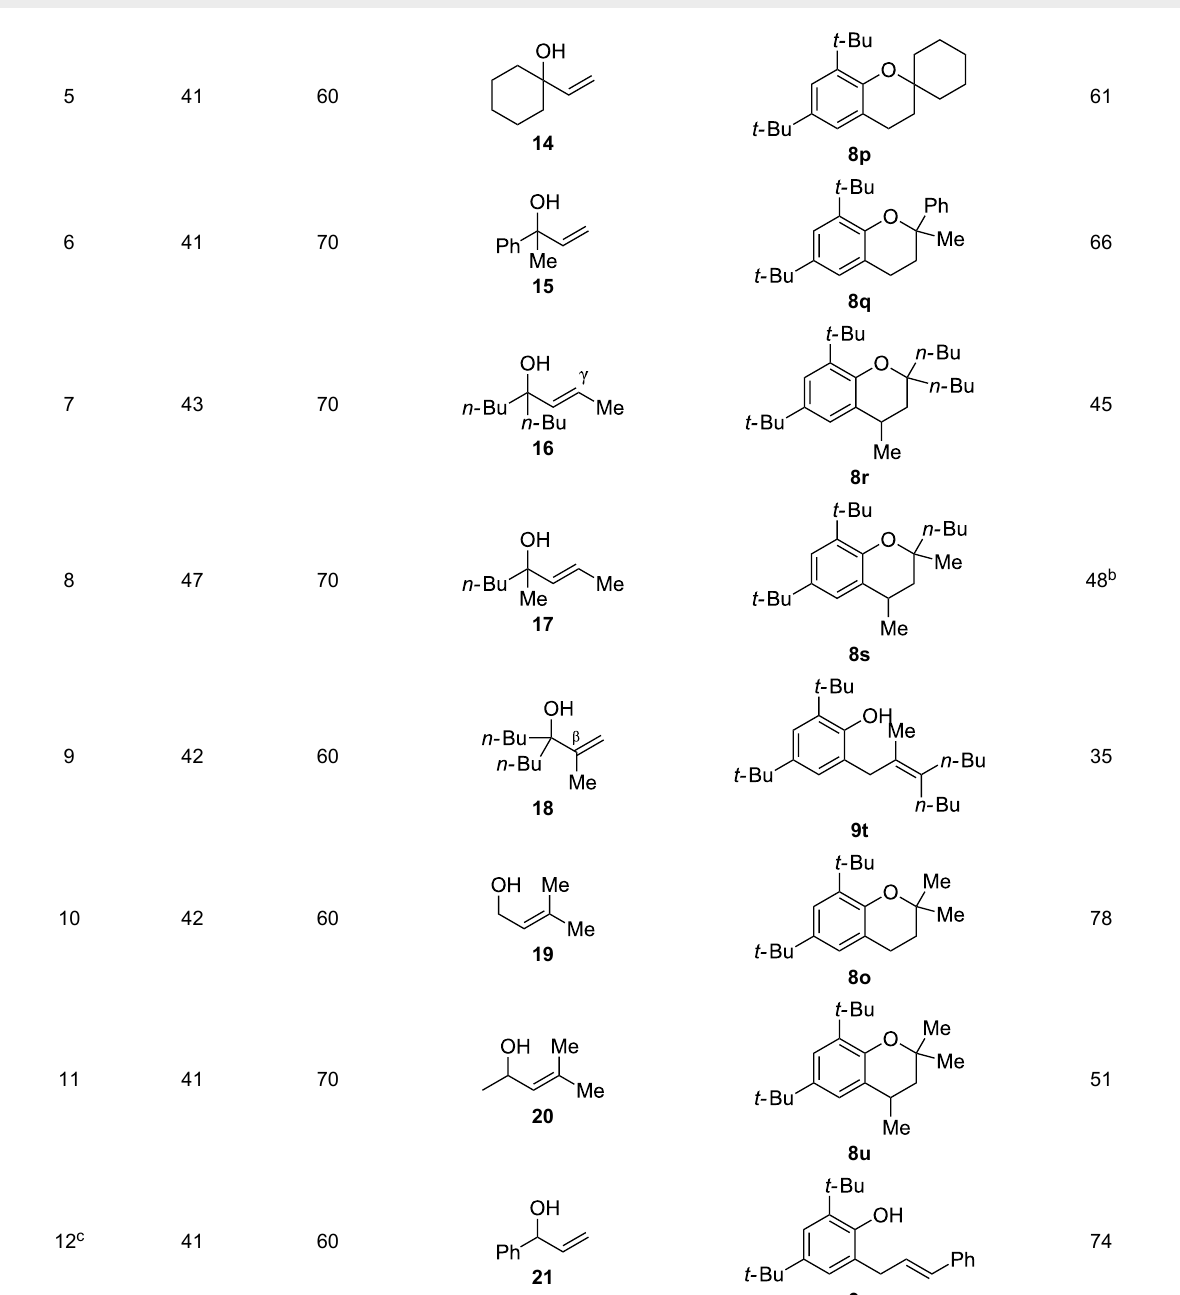
Table 3: Allylic alcohol scope.